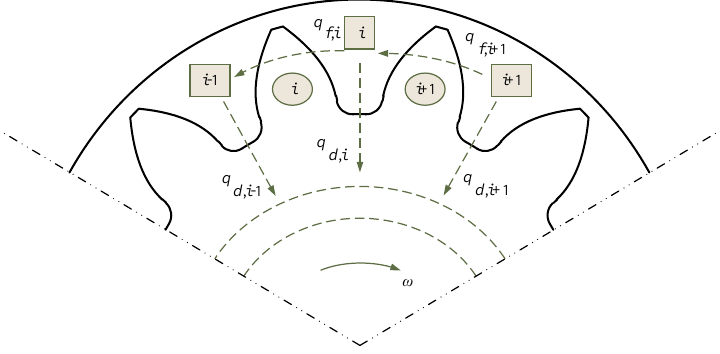
Figure 2. Schematic diagram of leakage path of gear pump end face.